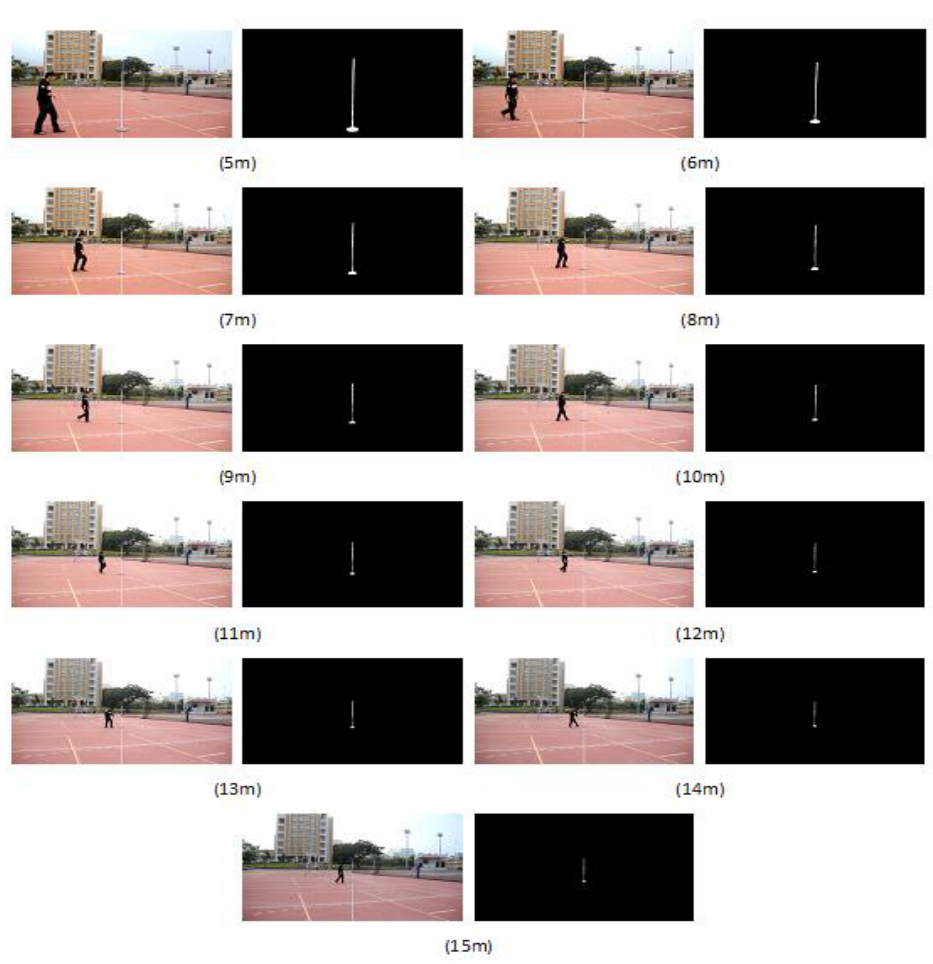
Figure 1. The test images; the objects height shows a linear relation corresponding to the distance between the rod and camera when the rod is varied from 5 m to 15